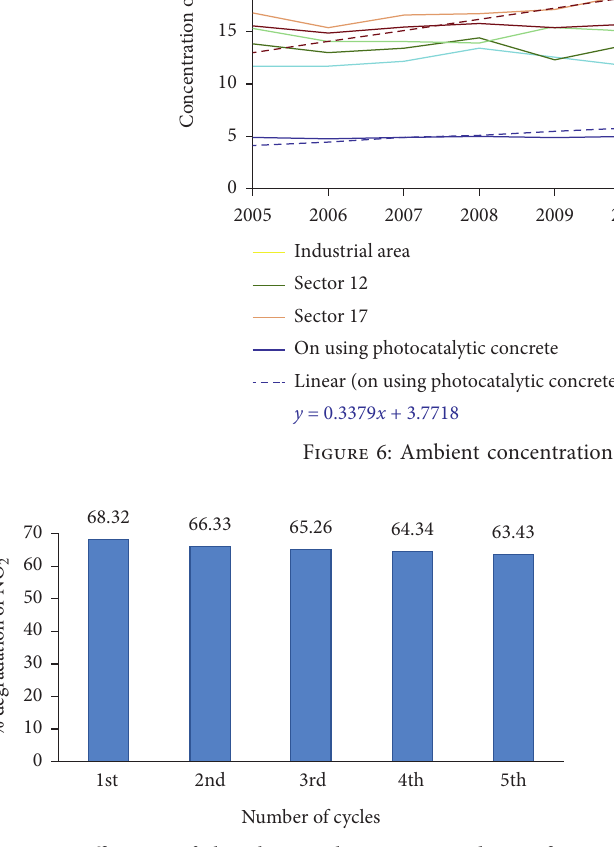
Figure 7: Efficiency of the photocatalytic concrete during five cycles of repeated